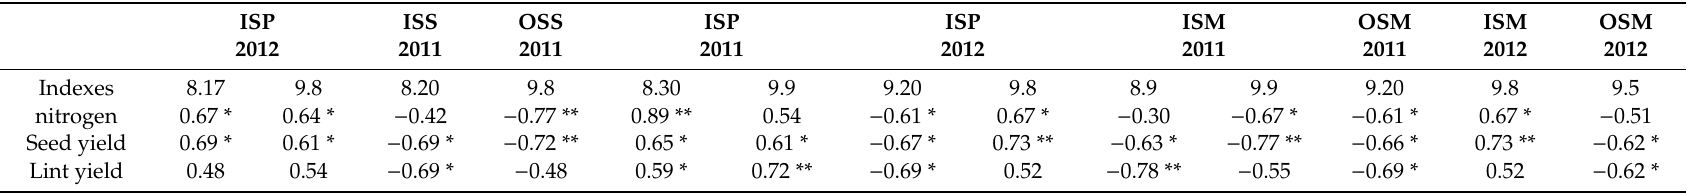
nitrogen 0.67 * 0.64 * − 0.42 Seed yield 0.69 * 0.61 * − 0.69 * − 0.72 ** 0.65 * 0.61 * 0.73 ** − 0.63 * − 0.77 ** − 0.66 * − 0.62 * Lint yield 0.48